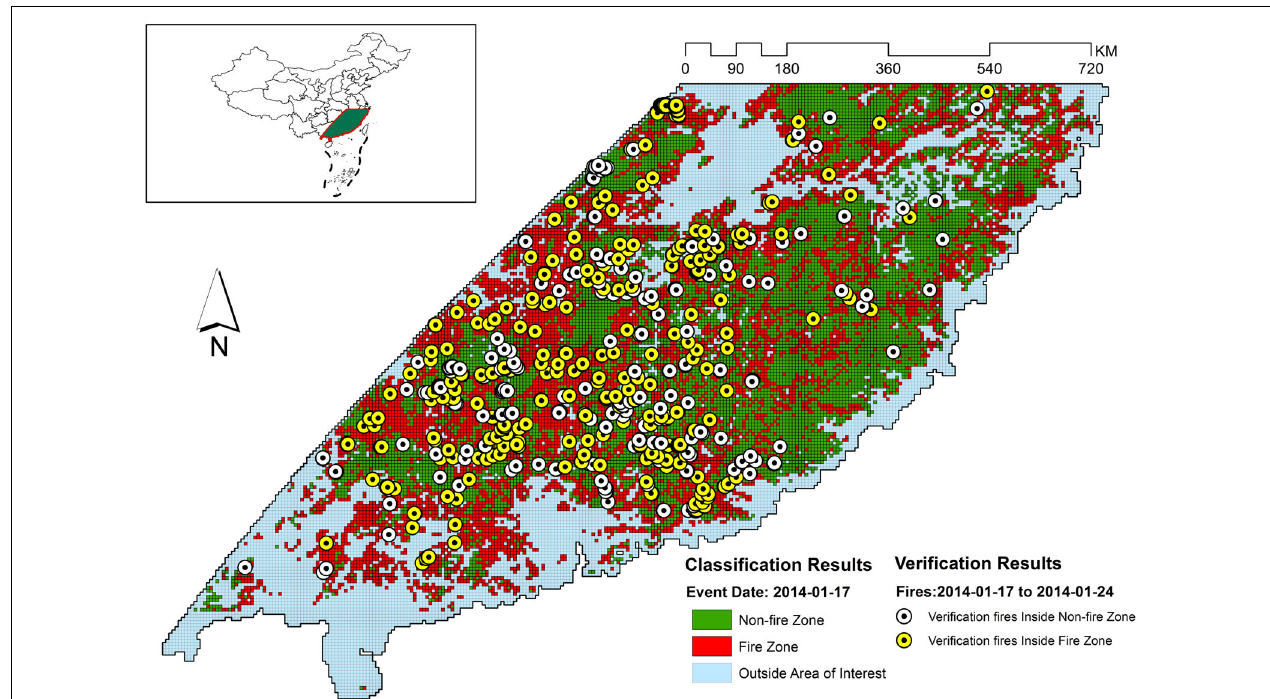
FIGURE 7 | Classification and verification result for 2014-01-17.